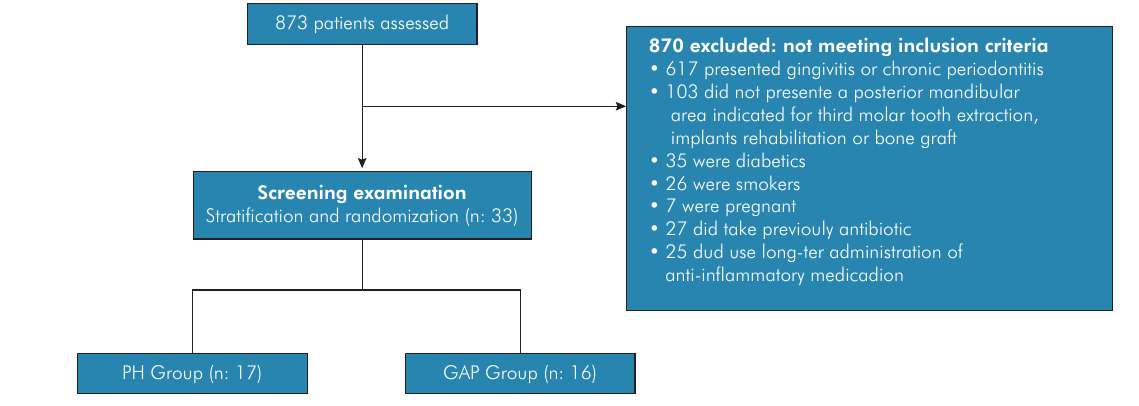
Figure 1. Flow diagram of participant